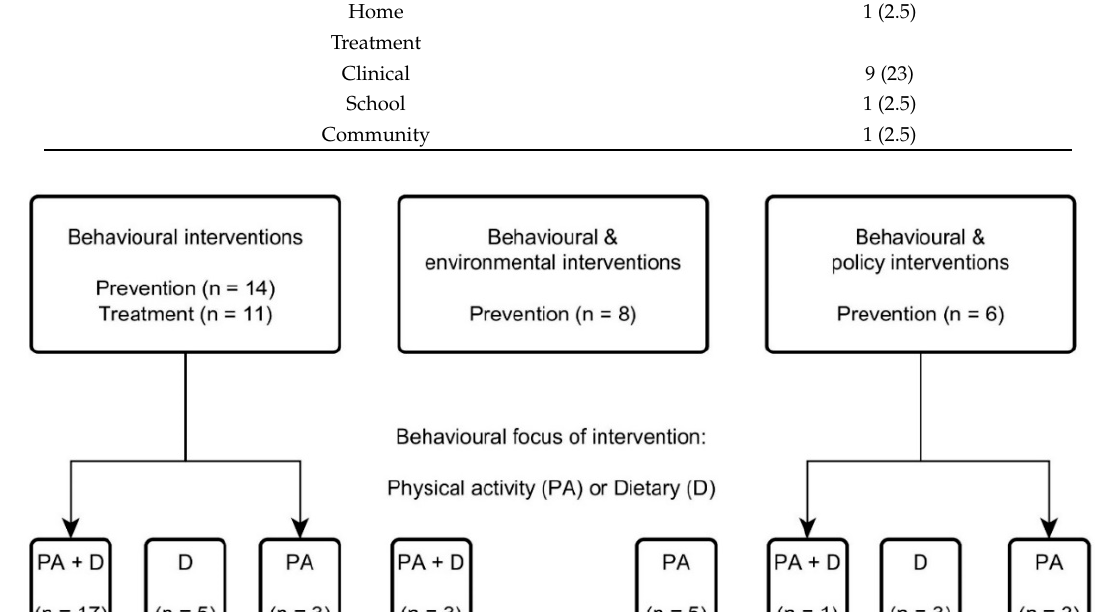
Figure 2. Summary of the interventions.